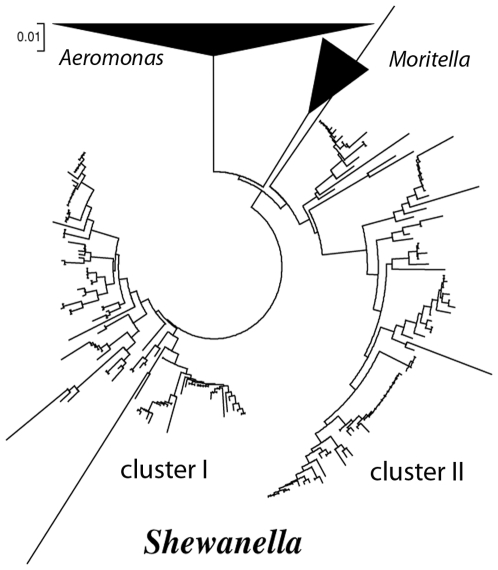
Phylogenetic analysis of partial 16S rDNA sequences of all cultivated and uncultivated Shewanella.The sequences of Shewanalla, Aeromonas and Moritella were all from GenBank (362 taxa in total). The phylogenetic tree was generated based on pair-wise nucleotide distance of Kimura two-parameter using the neighbour-joining method (pair-wise deletion, 3000 bootstrap value) included in the MEGA3 software package [68].